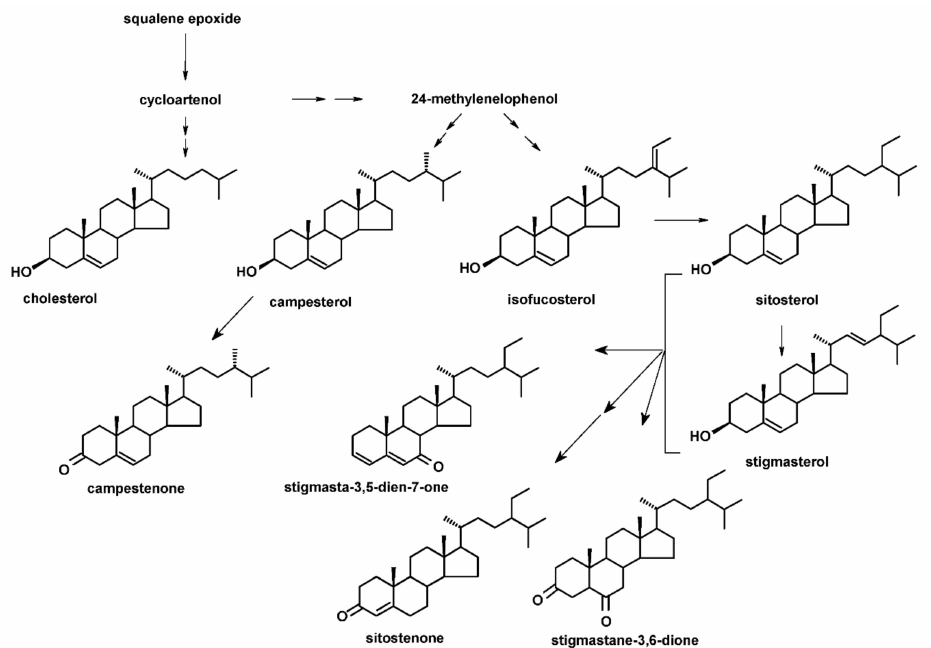
Figure 2. The structures of the steroids identified in T. × media hairy roots organized in simplified biosynthetic pathways (precursors and important branching points are incorporated in the scheme only as names). Three steroid ketones (stigmasta-3,5-dien-7-one, sitostenone and stigmastane-3,6- dione) can be derived from both sitosterol and stigmasterol.